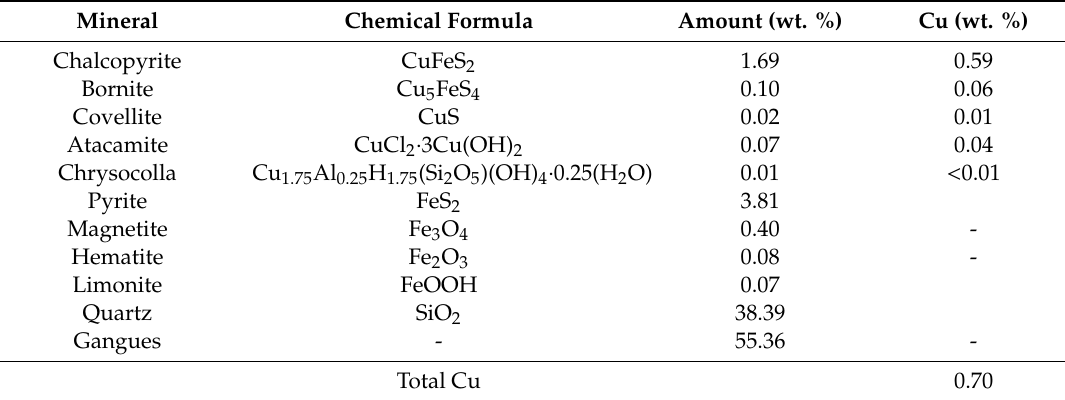
Table 1. Mineralogy of the ore determined by quantitative X-ray di ff raction. Mineral Chemical